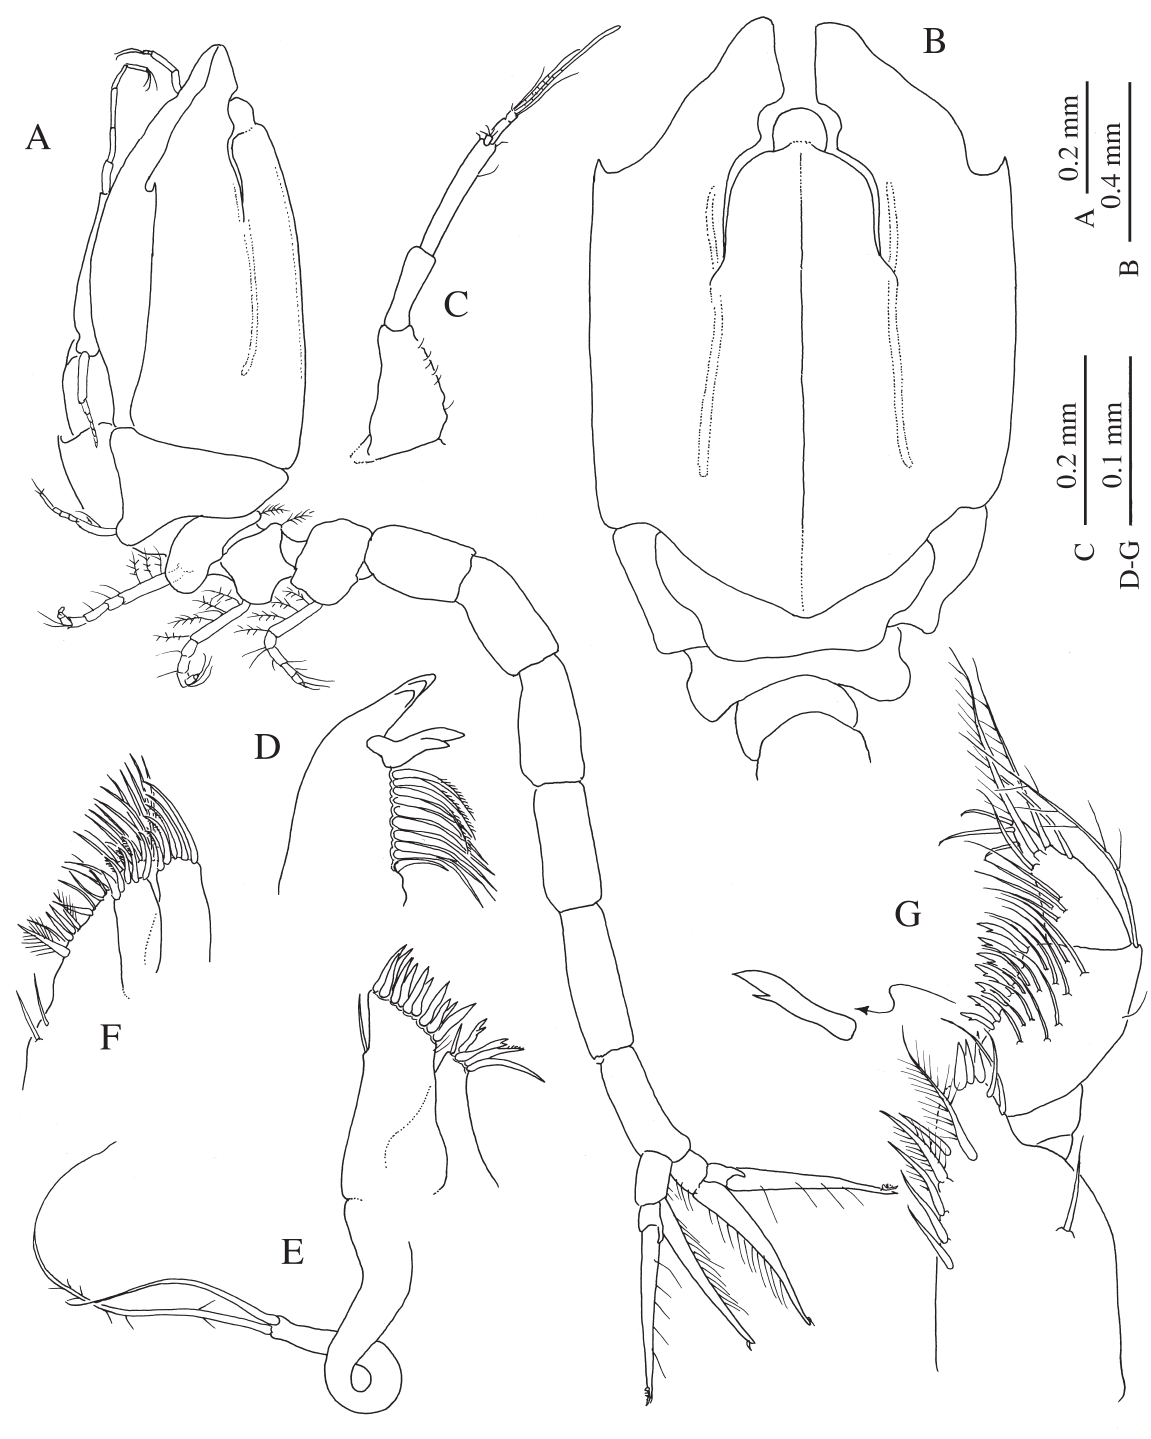
Fig. 2. – Eocuma rosae sp. nov., adult female, holotype: A, whole animal in lateral view; B, dorsal view of the carapace and last four thoracic segments. Preadult female, paratype: C, antenna 1; D, left mandible; E, maxillule; F, maxilla; G, maxilliped